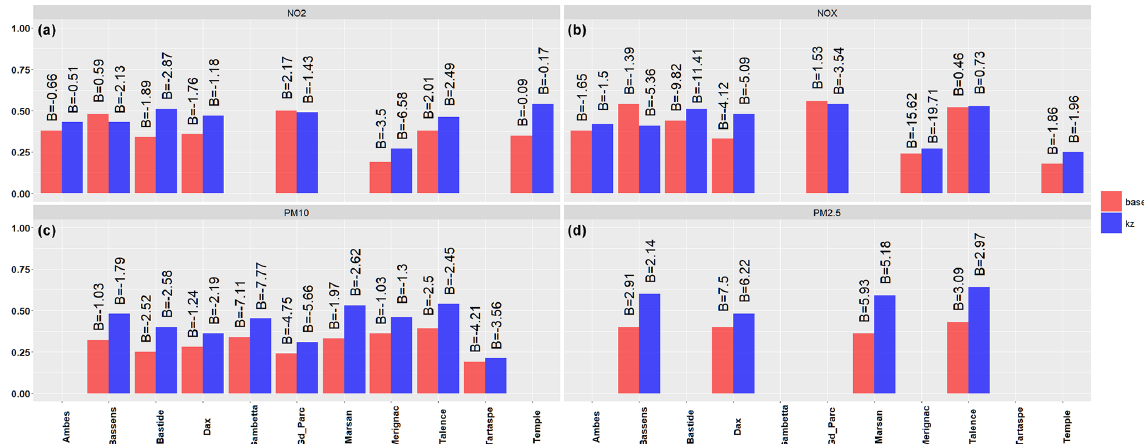
Figure 13. Statistics for the comparisons of measurements performed at air quality stations for NO 2 , NO x , PM 10 , and PM 2 . 5 in the sim- ulations. The y axis shows the correlation coefficient, while the bias (simulation–observation) for each station is written on each bar. The comparisons involve the base case (in red) and the final test case (in